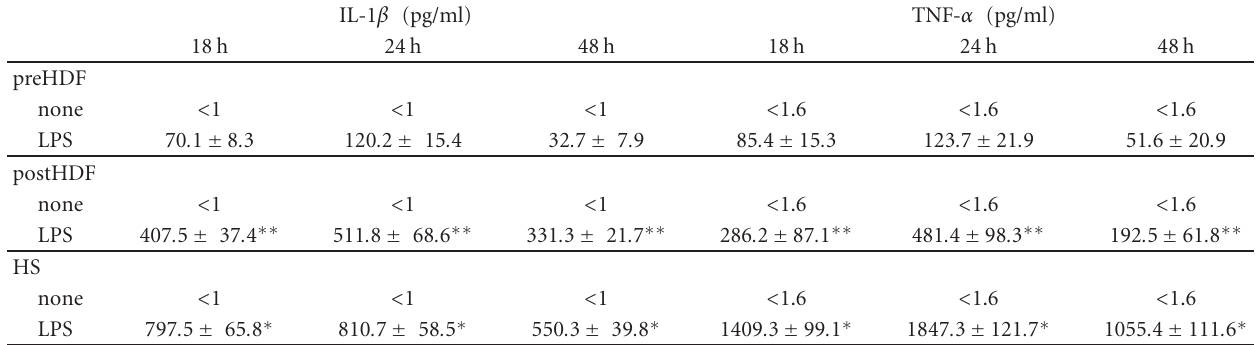
Table 2: Kinetics of IL-1 β (pg/mL) and TNF- α (pg/mL) release by PMG from preHDF and postHDF patients and